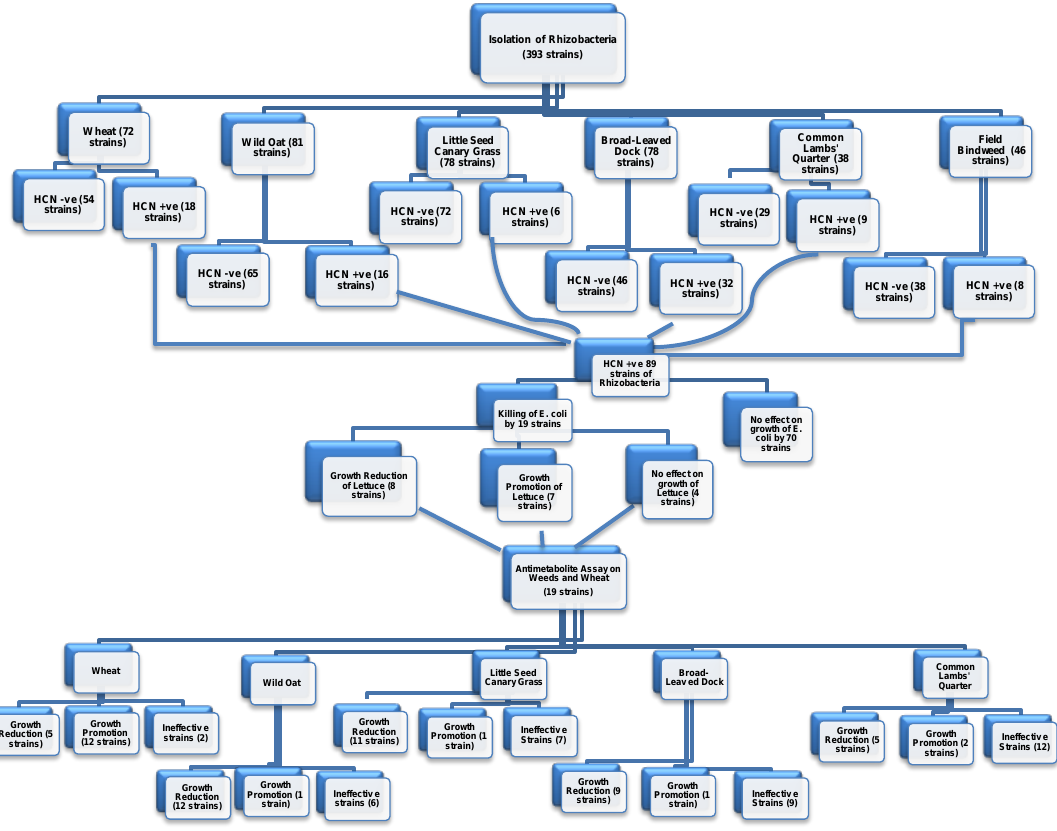
Figure 2. Flow chart of isolation and large-scale screening of allelopathic bacteria for the biocontrol of wheat-associated weeds.